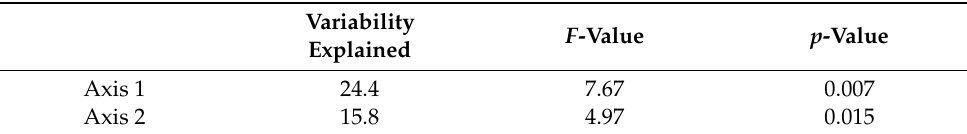
Table 7. Significance of the first two axes of the CCA model based on the Monte Carlo permutation test in CCA.